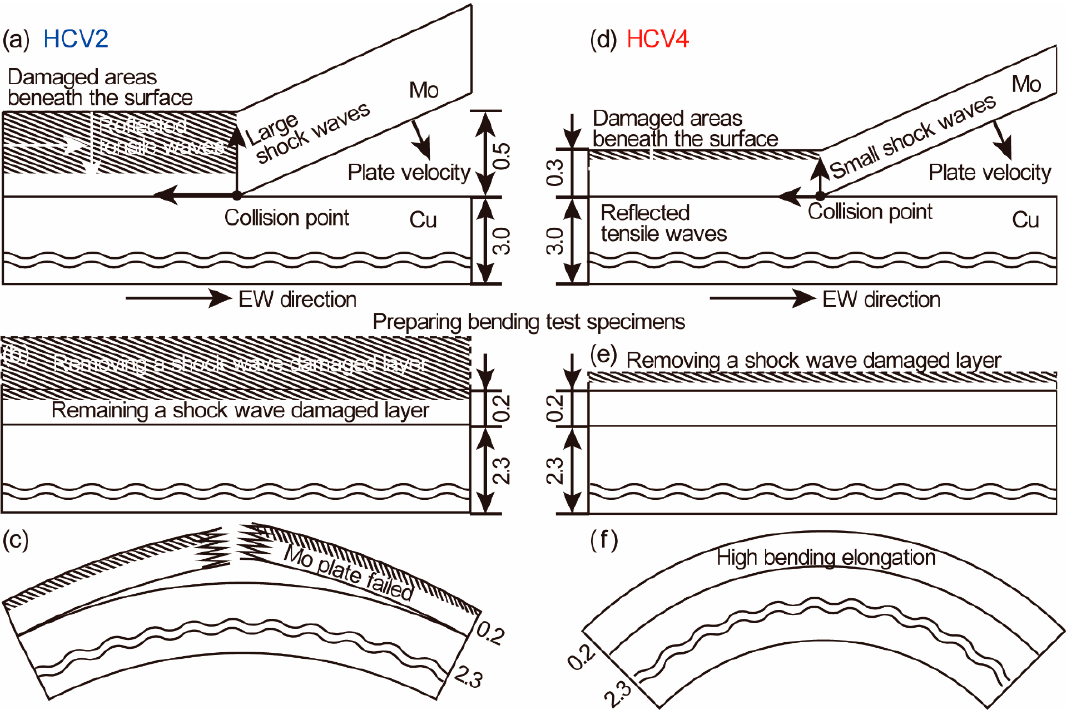
Figure 11. Schematic illustrations of ( a , d ) shock and reflected-tensile wave initiation during explosive welding and damaged areas beneath the Mo-plate surface, ( b , e ) preparation of bending specimens with a 0.25 mm-thick Mo plate, and ( c , f ) bending deformation of specimens and failure of a Mo plate for one specimen for HCV2 and HCV4 clads.